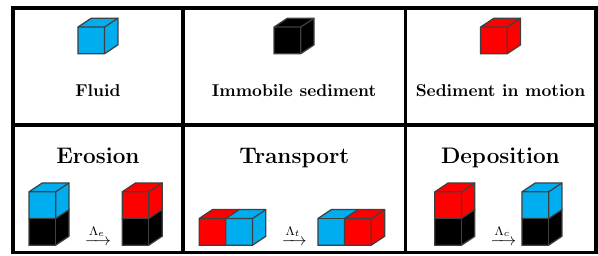
Fig. 3. States and active transitions of doublet in the simplified cellular automaton model for sediment transport. Three transitions rates 3 e , 3 t and 3 d with units of frequency (1 /t 0 ) are associated with erosion, transport and deposition, respectively. This simplified set of transition ensure that the sediment bed remains flat. When it is not the case, the cellular automaton model has to include horizontal transitions for erosion and diffusion as well as vertical transitions for deposition and transport (see the 10 transitions of the complete model in Narteau et al., 2009, Fig.